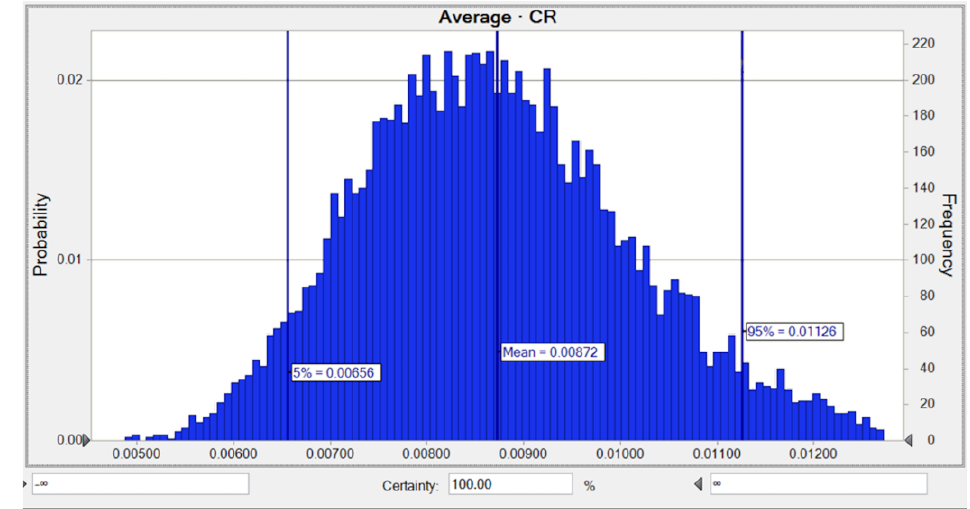
Figure 10. Predicted probability of TCR (children) for Ni in water.